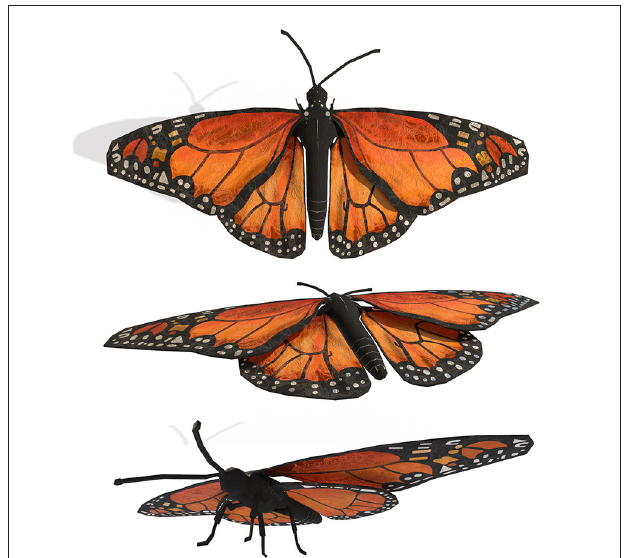
FIGURE 1 | Embedded context-sensitive